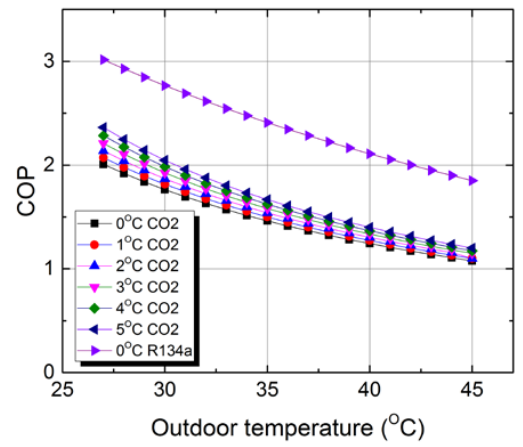
Figure 7. Effect of evaporation temperature on the COP of the CO 2 system.